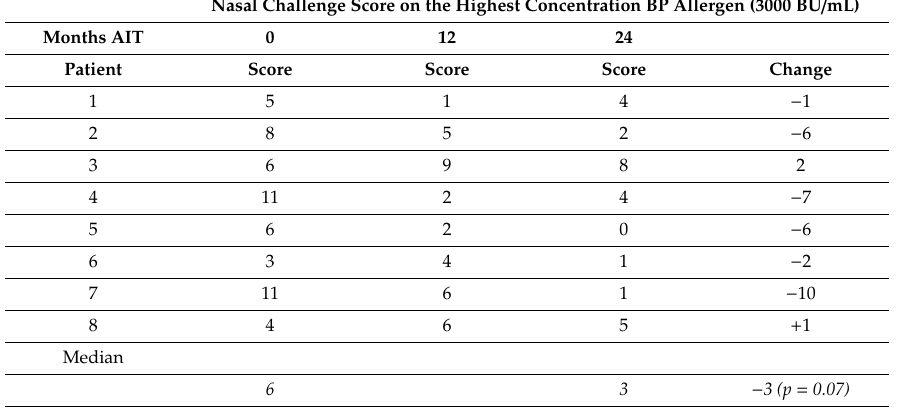
Table 1. E ff ect of the birch pollen immunotherapy measured with nasal